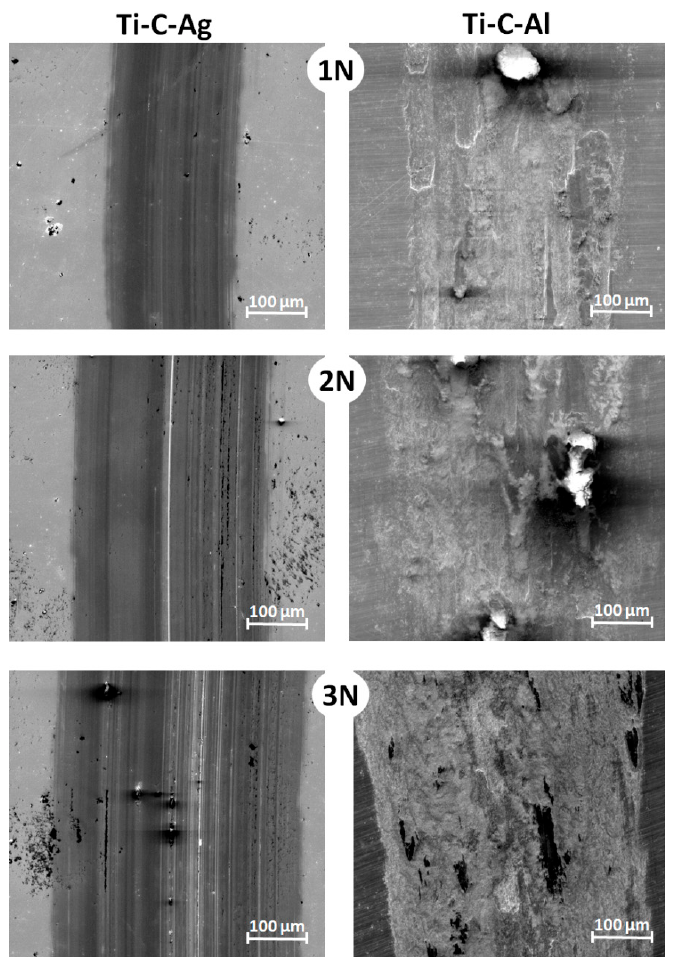
Figure 3. SEM images revealed from the wearing traces of Ti-C-Ag and Ti-C-Al thin films deposited on OLC 45 substrate.